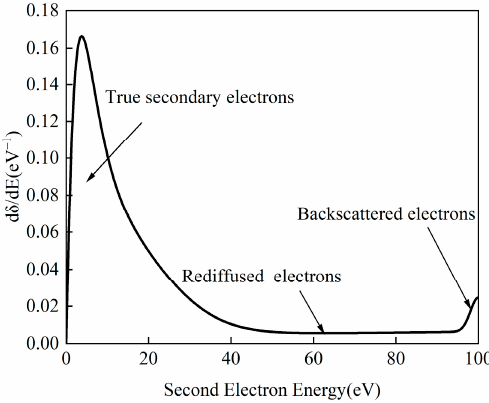
Figure 2. Secondary electron energy distribution.